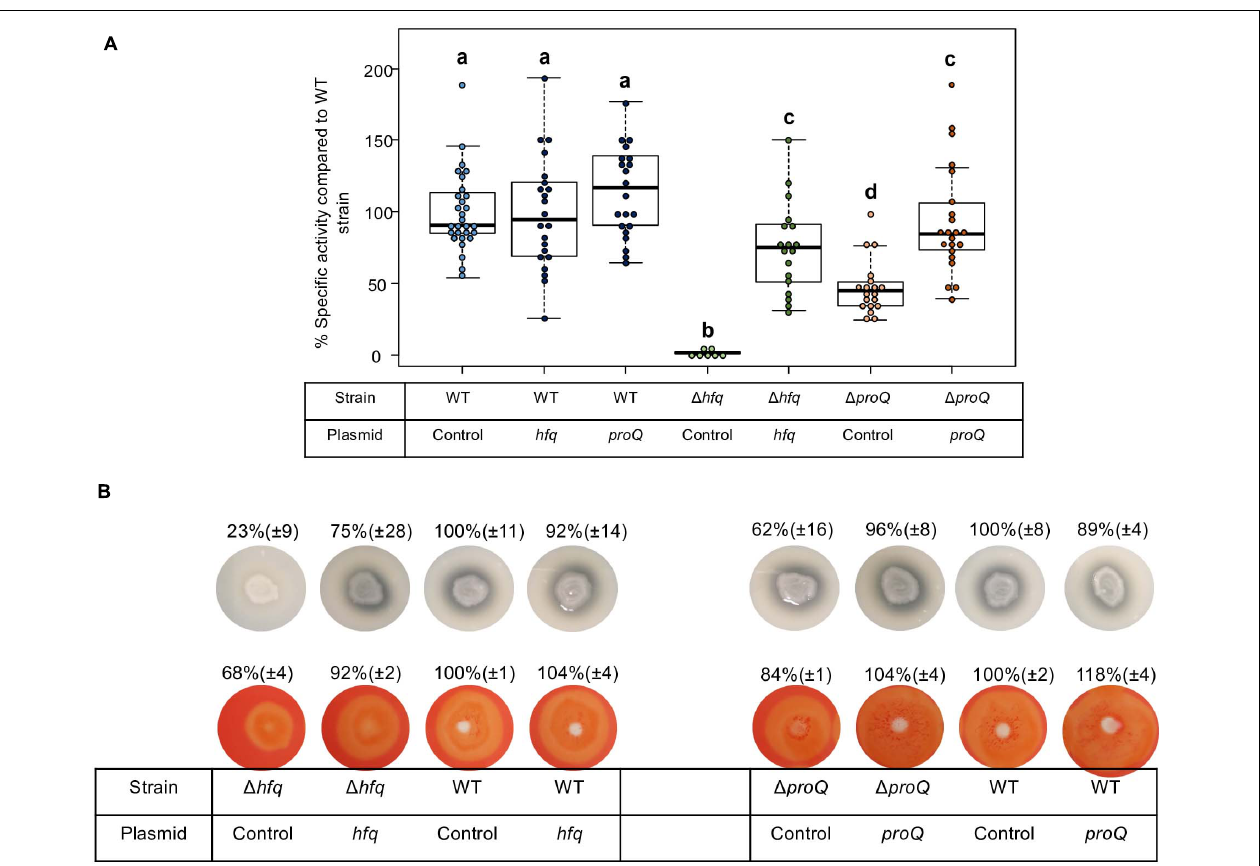
FIGURE 3 | Impact of Hfq and ProQ on cell-wall-degrading enzymes. (A) Pectate lyase activity in the wild type, mutant and complemented strains, expressed as percent of wild type strain specific activity. Experiments were repeated at least three times. Non-capital letters a, b, c, and d are presented above the boxplots. Groups with the same letter are not detectably different (are in the same set) and groups that are detectably different get different letters (different sets). Note that if the groups have the same letter, this does not mean they are the same, just that there is no evidence of a difference for that pair ( P < 0.05, Wilcoxon Mann-Whitney test). (B) Protease production on medium containing skim milk, and cellulase production on carboxymethylcellulose agar plate with Congo red staining in the hfq and proQ mutants, the complemented strains and the wild type